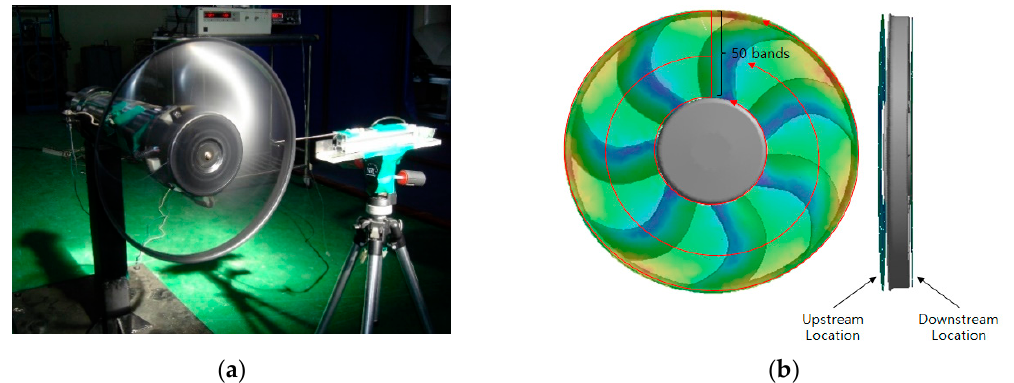
Figure 5. Experimental equipment for velocity measurements ( a ) and numerical velocity-averaged method with radial bands of 50 ( b ).